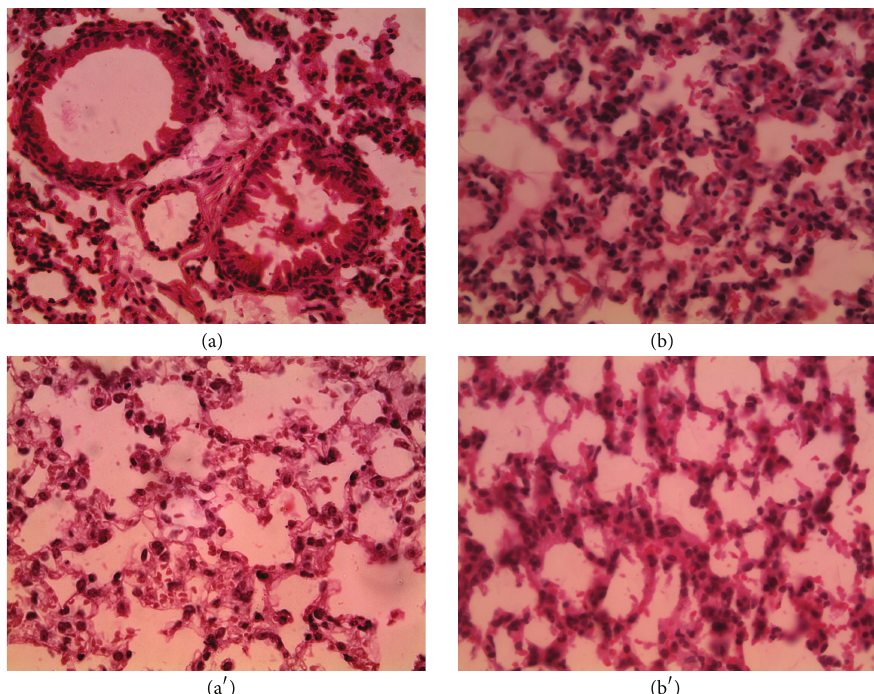
Figure 7: Lung sections. ((a) and (a 󸀠 )) Control, magnification 40x, ((b) and (b 󸀠 )) high concentration, magnification 40x. (a), (b) males; (a 󸀠 ), (b 󸀠 ) females.